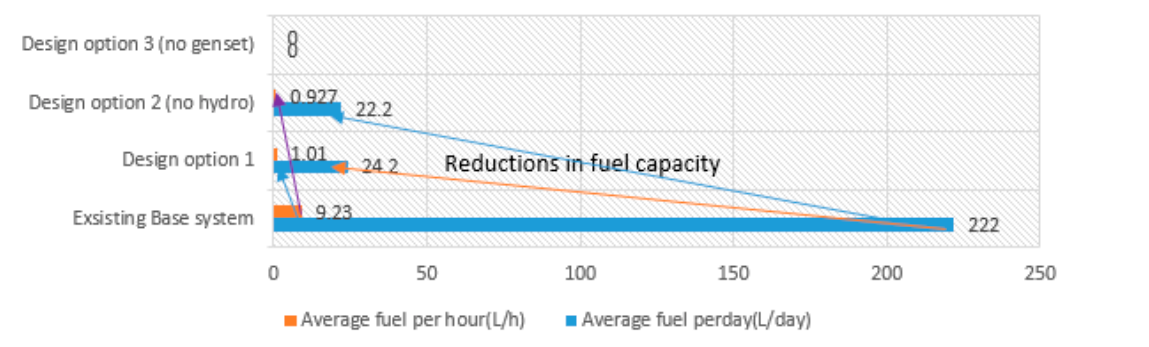
Figure 17. Comparison of systems’ average fuel consumption per day and per hour.